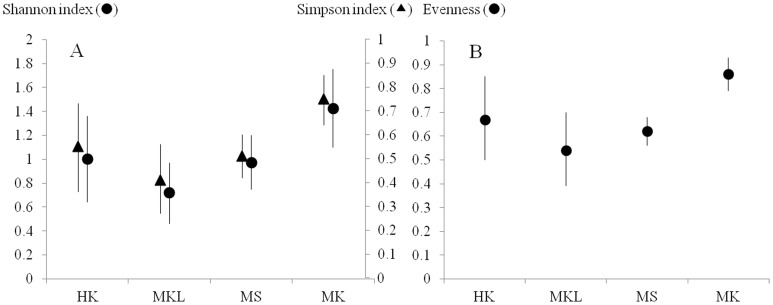
Estimates of diversity for riparian fig tree species at four study sites: (HK) Huay Kaew stream, (MKL) Mae Klang stream, MaeS (MS) stream and Mae Ka stream (MK).(A), mean diversity (±95% CI) for each site according to the Shannon’s index (circles) and Simpson index (triangles). (B), evenness at each study site is based on the Shannon’s index (circles); vertical lines indicate the 95% CI.